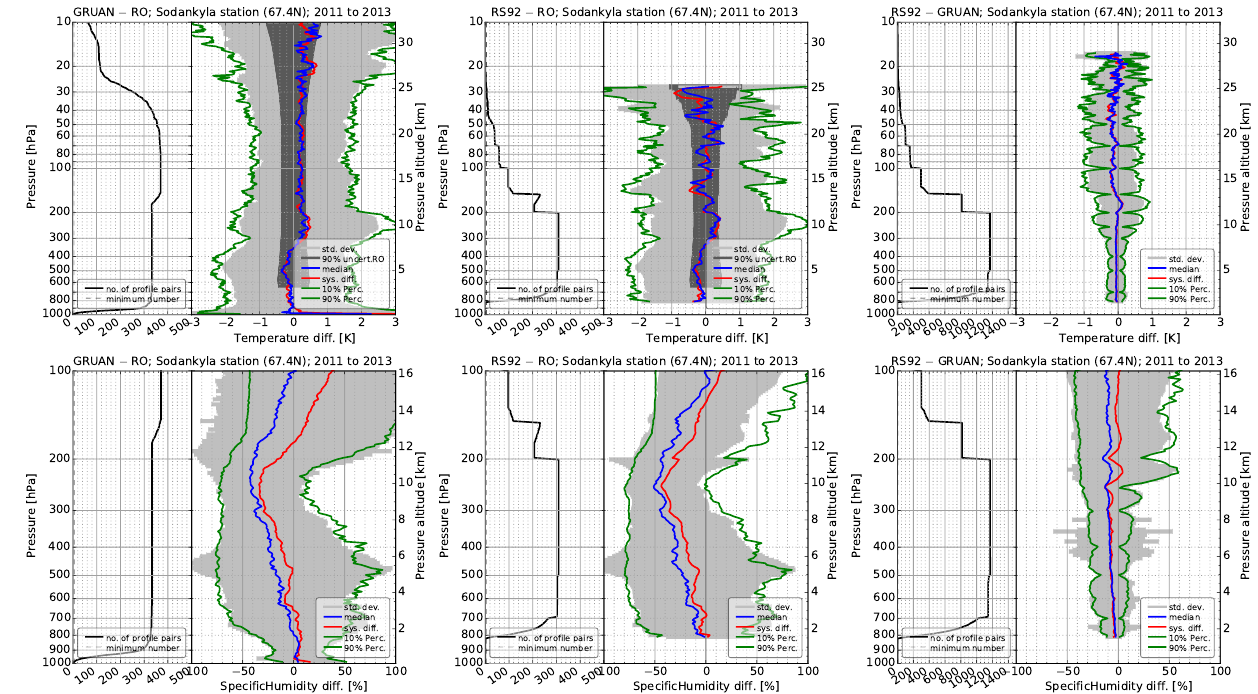
Figure 10. Same layout as Fig. 7, but for the GRUAN station in Sodankylä,